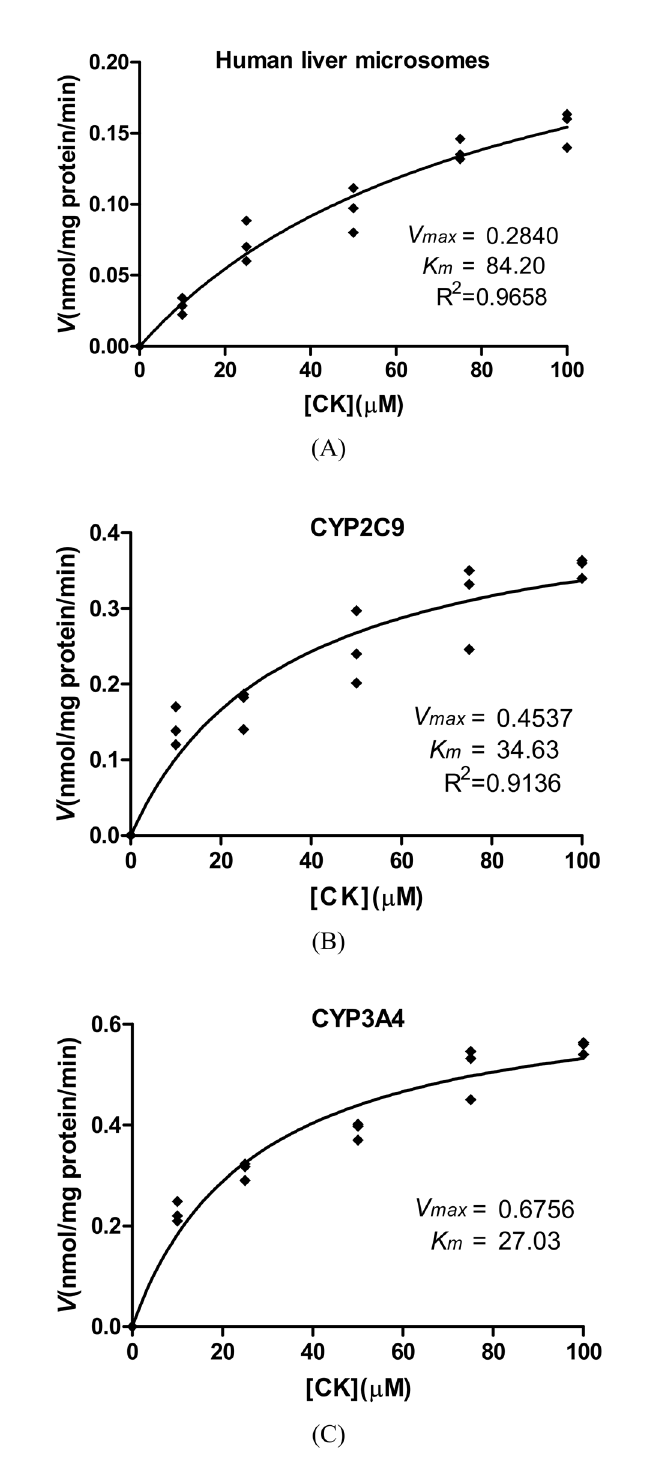
Fig 2. Concentration-velocity curve of CK metabolism after incubation with HLMs (A), recombinant CYP2C9 (B) and recombinant CYP3A4 (C). Note: The incubation conditions are described in the materials and methods section. The curve was automatically fitted using nonlinear regression and the Michaelis – Menten equation. Data were obtained in triplicate.